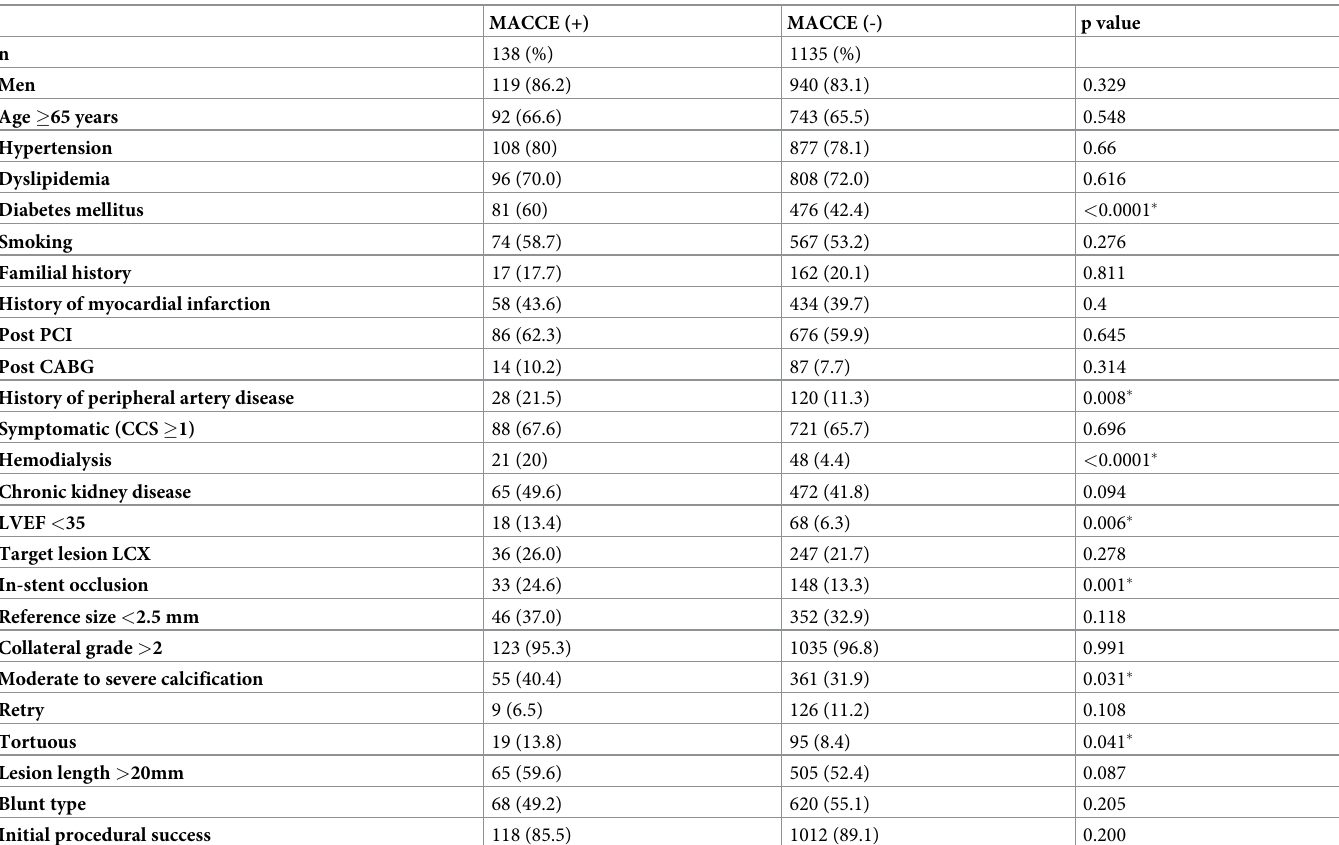
Table 2. Univariate analysis for the incidences of MACCE in the derivation group.